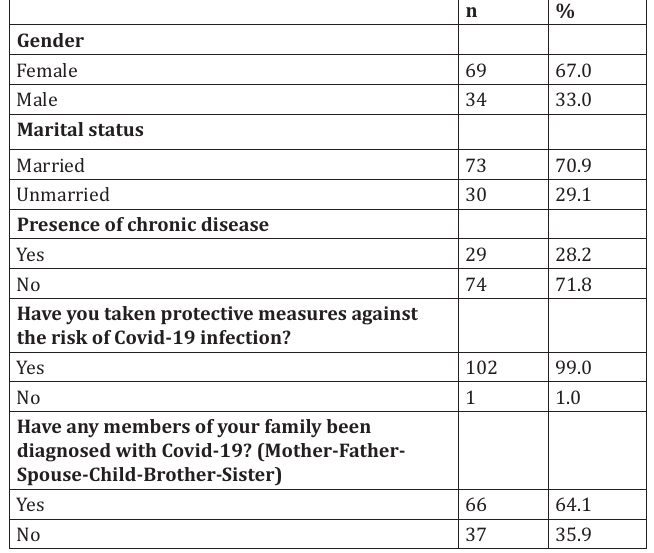
Sociodemographic characteristics of the study